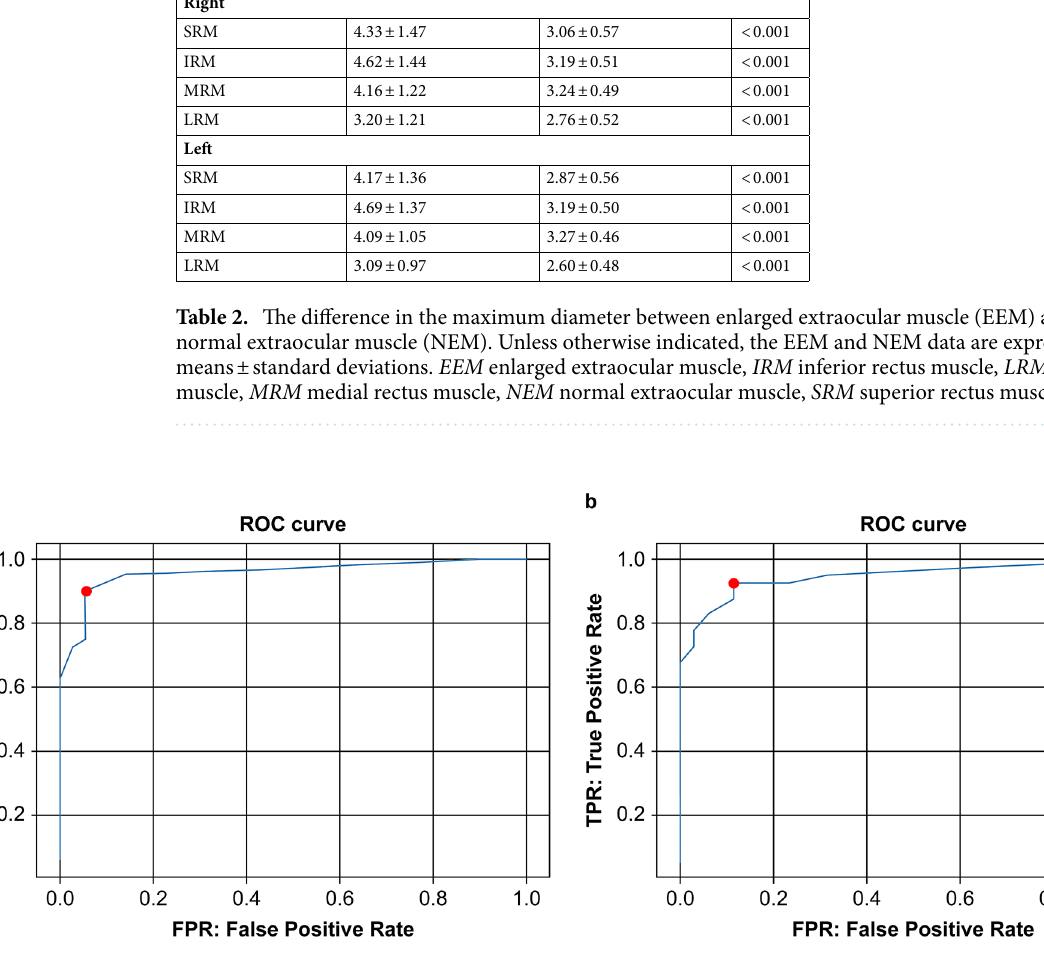
Figure 1. ( a ) Receiver operating characteristic (ROC) curve for the validation data. The area under the curve (AUC) for diagnosis by the neural network was 0.953, and ROC analysis revealed 89.7% sensitivity and 94.3% specificity. ( b ) ROC curve for the test data. The AUC for diagnosis by the neural network was 0.946, and ROC analysis revealed 92.5% sensitivity and 88.6%